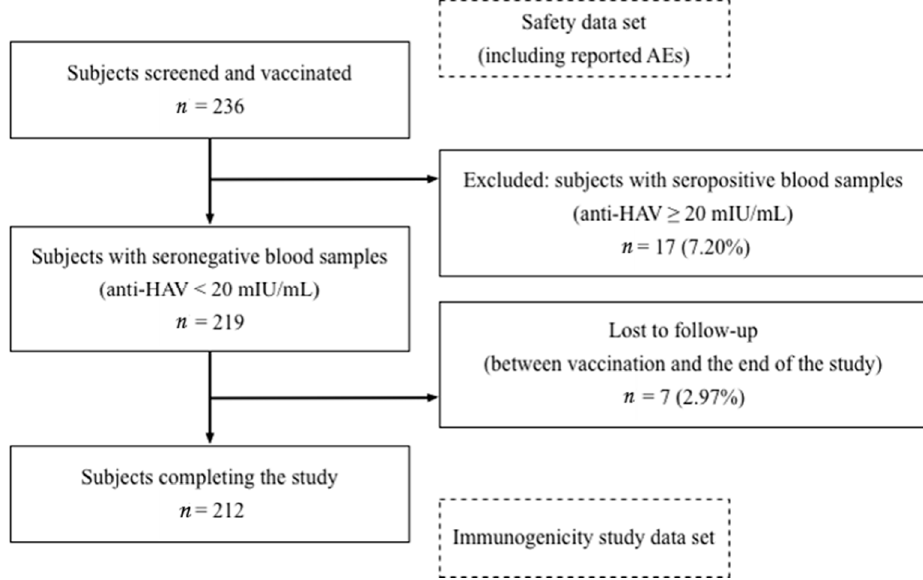
Figure 1. Disposition of subjects in the study.